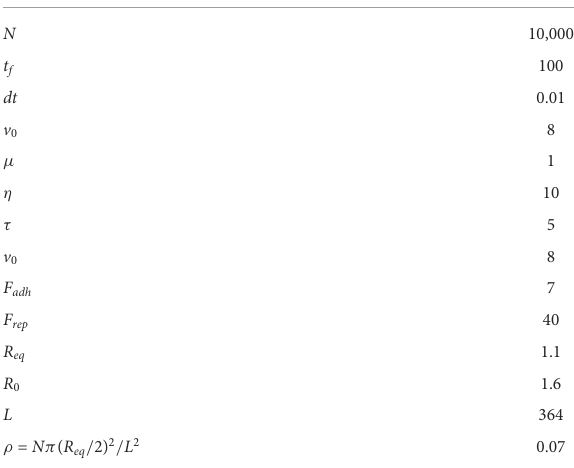
TABLE 1 Model parameters